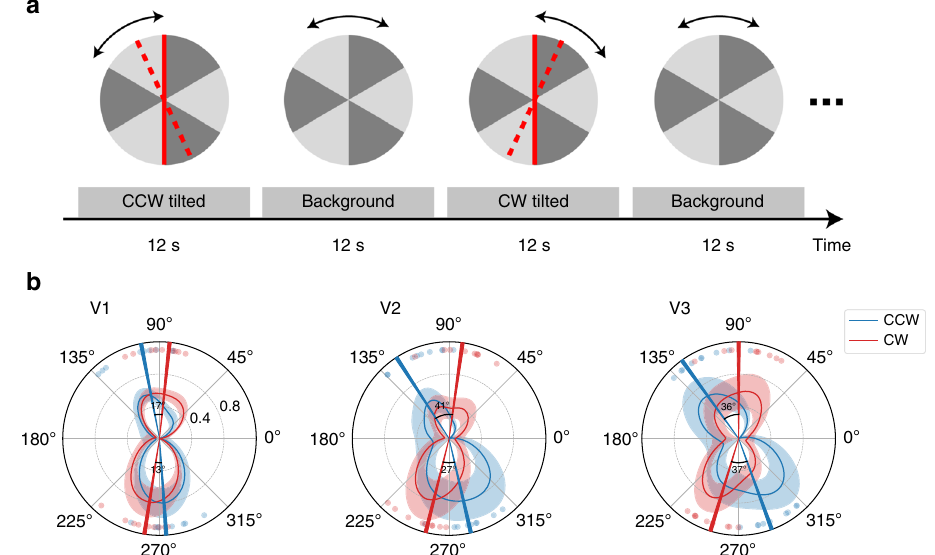
Fig. 2 Stimuli and results of the 3T fMRI. a Schematic diagram of stimuli and procedures for the 3T fMRI experiment. A red bar fl ashed repeatedly for 12 s at the reversal point of the background motion, alternating with 12 s background-only stimulation. The bar was presented at the vertical meridian but would be perceived as tilted clockwise or counter-clockwise from the vertical, depended on the direction of motion reversal. Red solid lines indicate the original position of the bar, while red dotted lines illustrate subjects ’ perception of the bar. b Polar angle representation of the fl ashed bar in FGE in the early visual cortex. Normalized fMRI response to the clockwise and counter-clockwise tilted illusions were plotted as a function of polar angle coordinates across the visual fi eld. The minimal and maximum polar response for each subject were normalized to 0 and 1 ( fi rst subtracted the min and then divided by the max). Red and blue curves show the average polar response across subjects (low pass fi ltered by convolving with a 60°-width hamming window for illustration purposes). Shaded areas indicate standard errors of the mean ( n = 9 (individual subject)). Red and blue bars illustrate the estimated average tilt from the curves, whereas the dots indicate the estimated tilt for individual subjects. Source data are provided as a Source Data fi